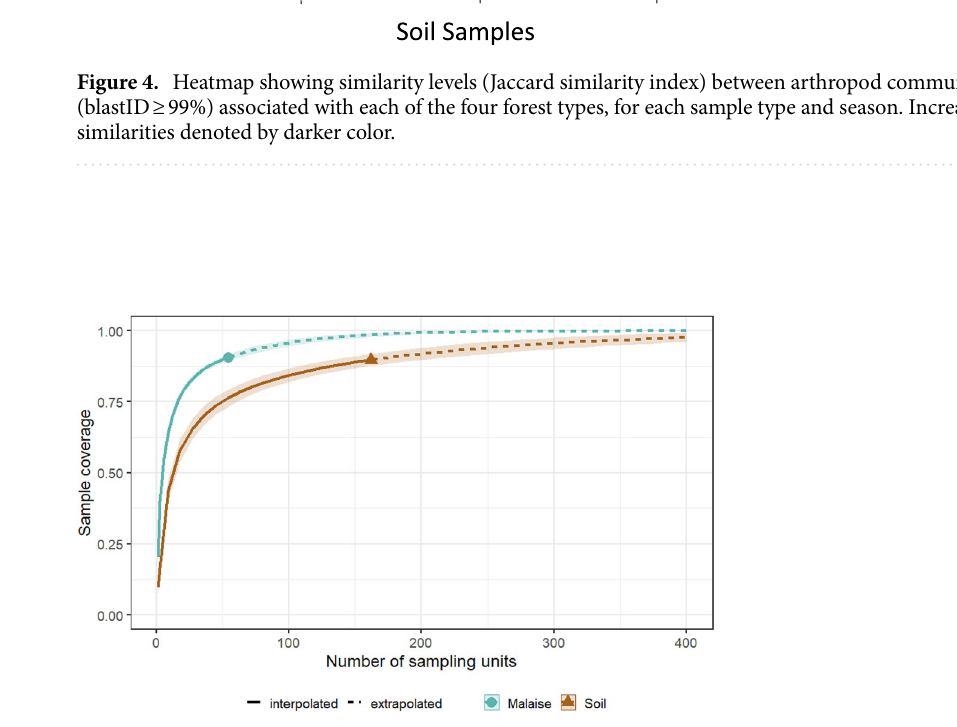
Figure 5. Sample completeness curves showing diversity estimates with respect to sample coverage for the different sample types, Malaise trap (green) and soil samples